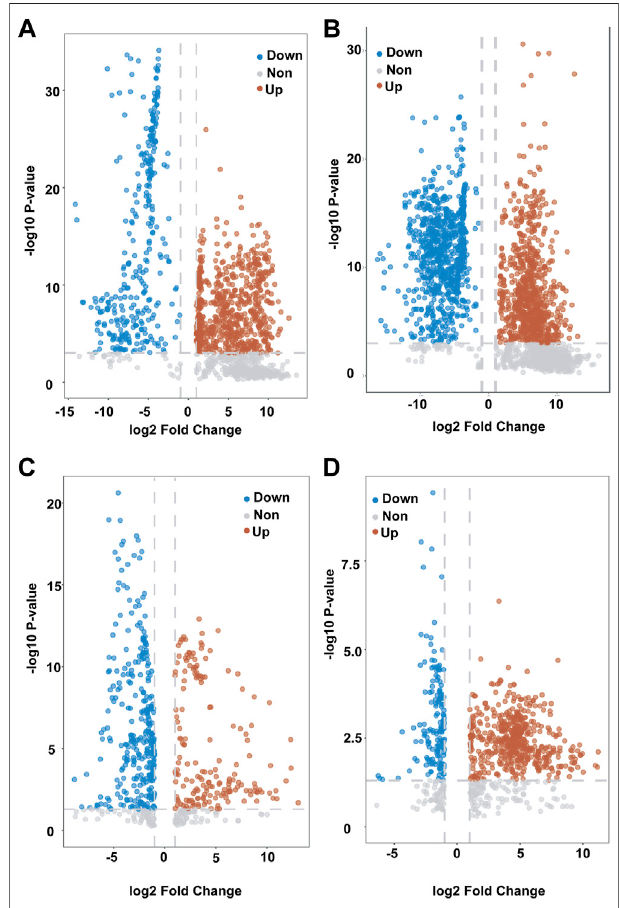
FIGURE 3 | Candidate biomarkers in serum of patients with different types of leukemia. (A,B) : Differential metabolite volcanic map between group A and group D in negative/positive mode. (C,D) : Differential metabolite volcanic map between B and group C in negative/positive mode. Group A Acute lymphoblastic leukemia group D.(include group B and group C): Acute myeloid leukemia.